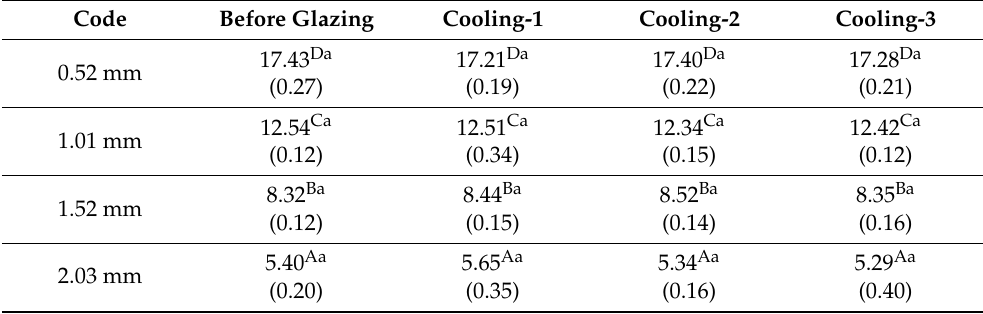
Table 6. Translucency parameter (TP) for each group of the zirconia specimens with different thicknesses (mean ±